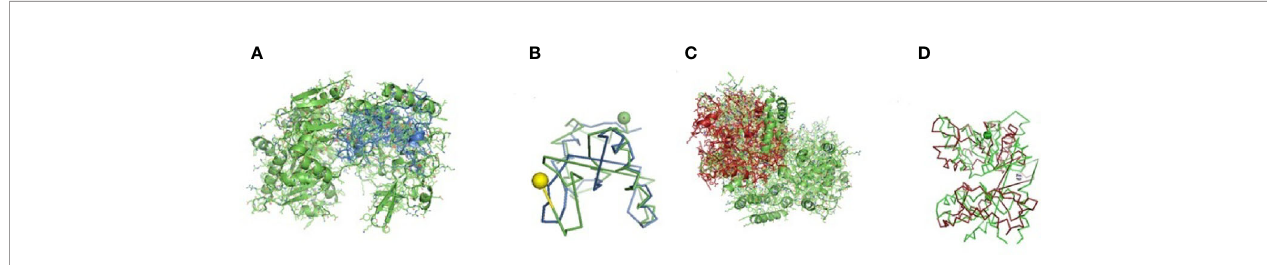
FIGURE 6 | (A, B) Molecular docking of parasitic protein 15 kDa secretory protein with ovine RIG-I, alignment (left) and binding site (right). (C,D) Molecular docking of parasitic protein Pgp1 with ovine RIG-I, alignment (left) and binding site (right).